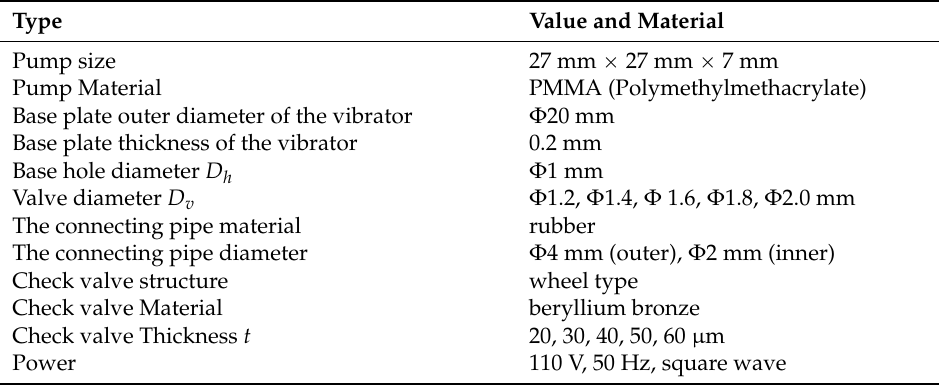
Table 1. The parameter of the